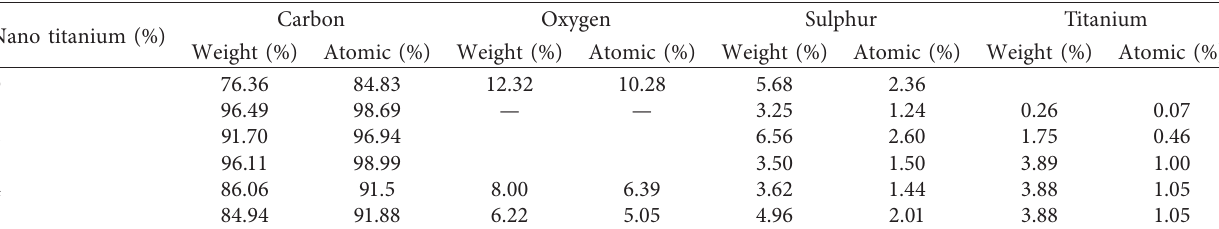
Table 3: Unmodified and modified bitumen